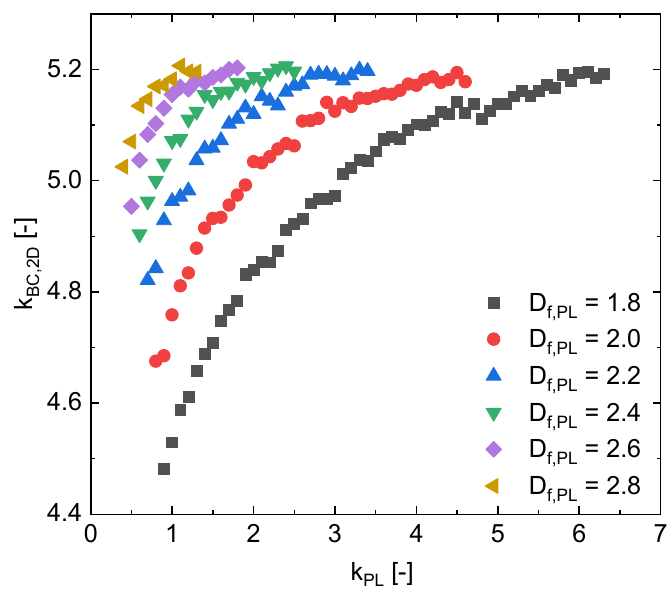
Figure 9. Relationship between k PL and k BC ,2 D based on various D f , PL (=1.8:0.2:2.8). In Figure 9, 𝑘 (cid:3003)(cid:3004),(cid:2870)(cid:3005) is seen to increase with increasing 𝑘 (cid:3017)(cid:3013) ; however, the growth rate of 𝑘 (cid:3003)(cid:3004),(cid:2870)(cid:3005) decreases as 𝑘 (cid:3017)(cid:3013) increases. As pointed out in Section 3.2, 2D BC fractal proper-